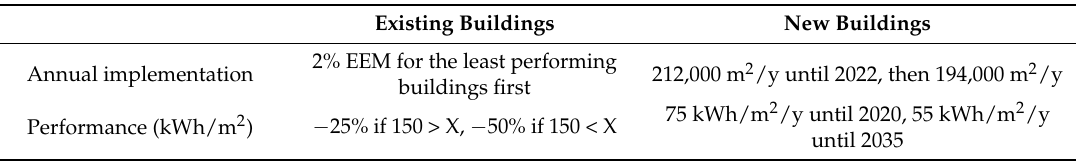
Table 2. Key features of the assumed building-stock